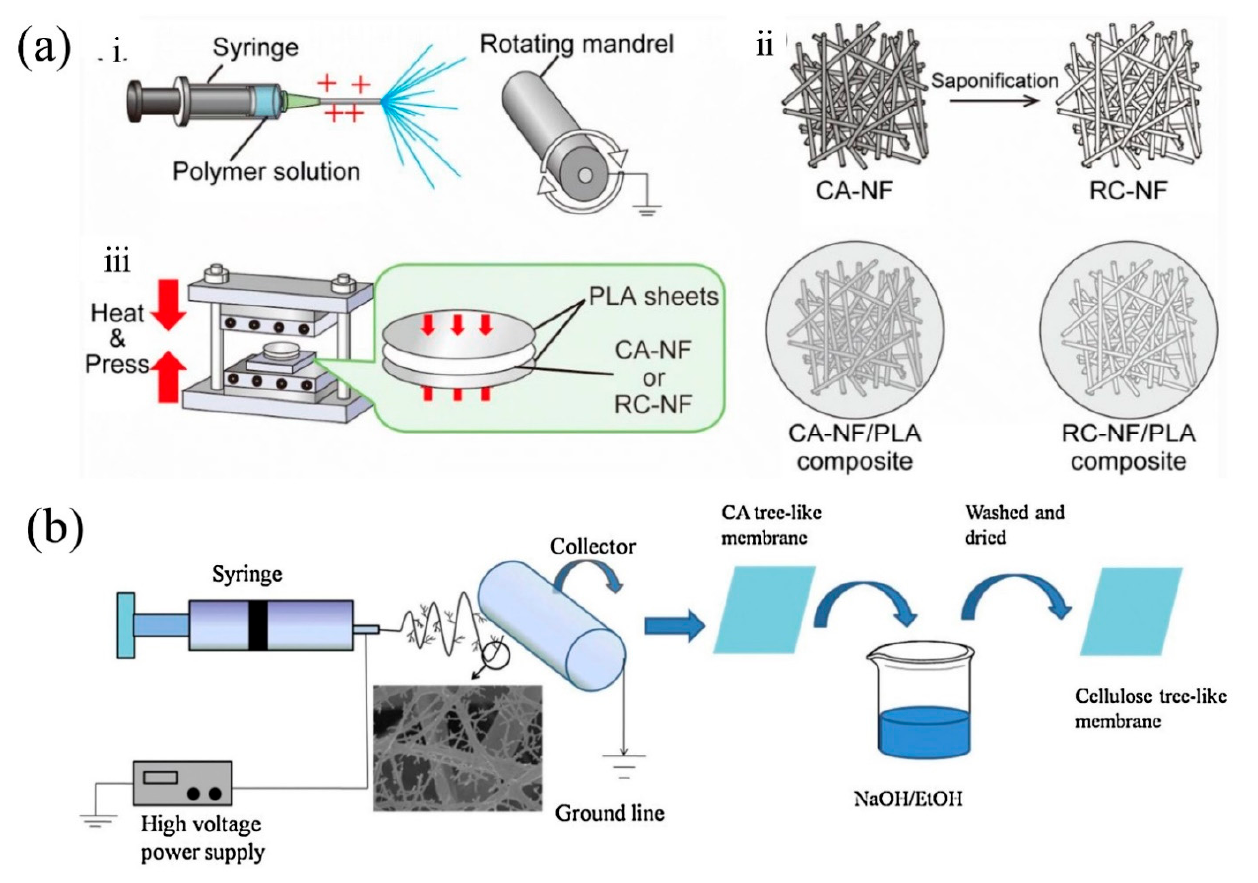
Figure 11. ( a ) ( i ) Electrospinning setup for fabrication of CA-NF; ( ii ) saponification of CA-NF to obtain RC-NF; ( iii ) compression molding for the fabrication of CA-NF/PLA and RC-NF/PLA composite films. Reprinted with permission from ref. [78]. Copyright 2019 Springer Nature B.V. ( b ) Schematic diagram for the preparation of tree-like cellulose nanofibers. Reprinted with permission from ref. [79]. Copyright 2017 Elsevier